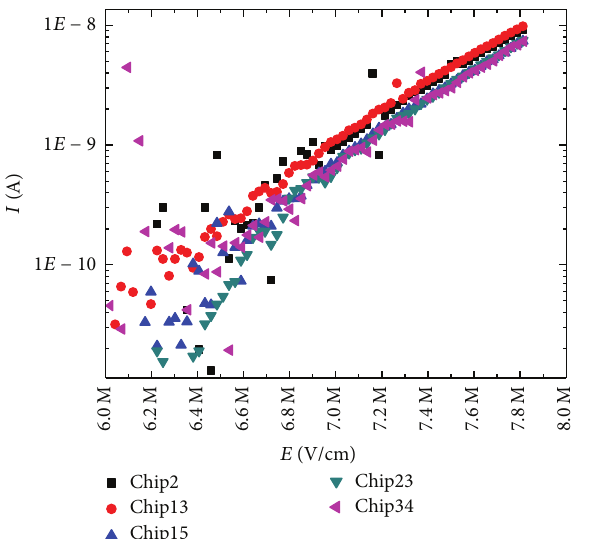
Figure 1: Measured tunneling current from five different capacitors 𝐼 versus E.